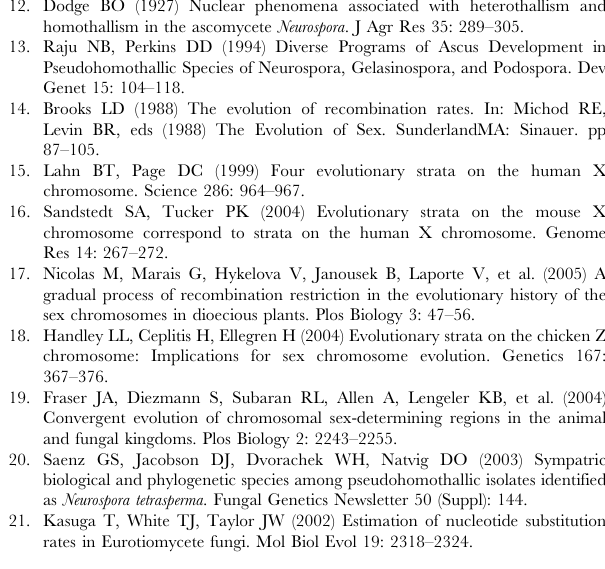
Table S2, enzymes were obtained from Fermentas Life Sciences, Germany, and digestion was performed according to the manufacturer’s recommendations. Genetic markers were scored as described previously [11]. Recombination frequencies between the markers were compared to those expected for wild-type N. crassa .